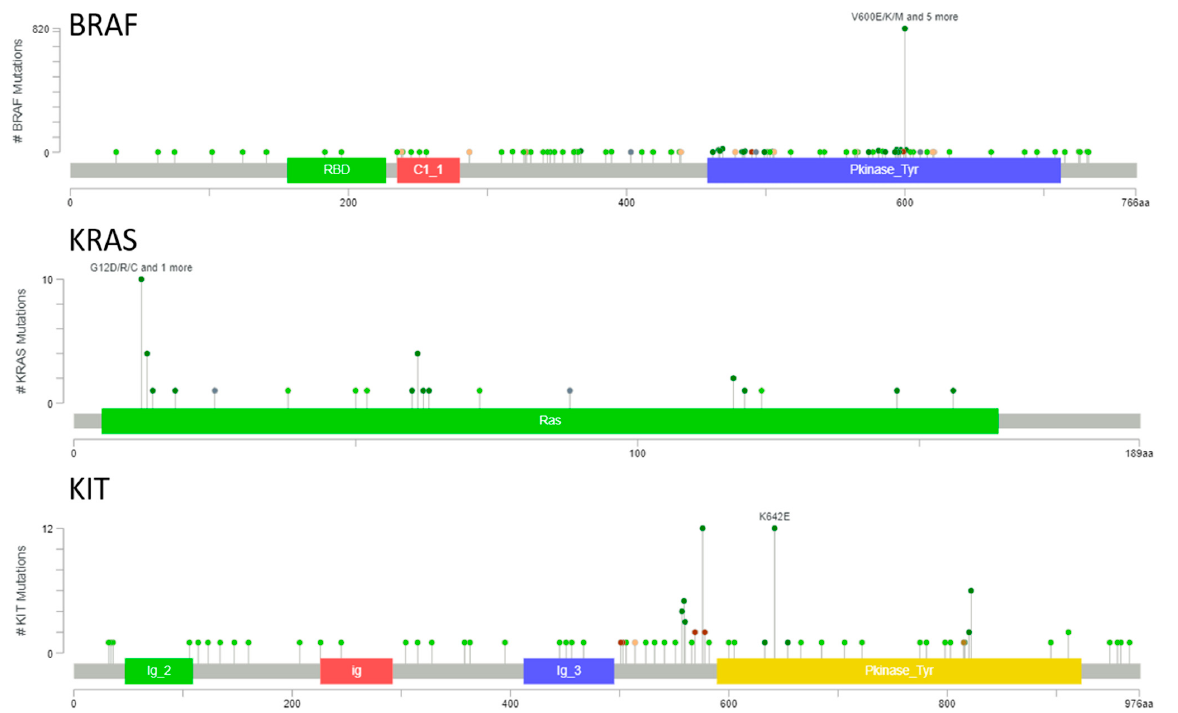
Figure A1. Graphical representation showing the distribution of mutations (color-coded as Figure 1) across the protein- coding regions of the three mutated oncogenes ( BRAF , KRAS , and KIT ).